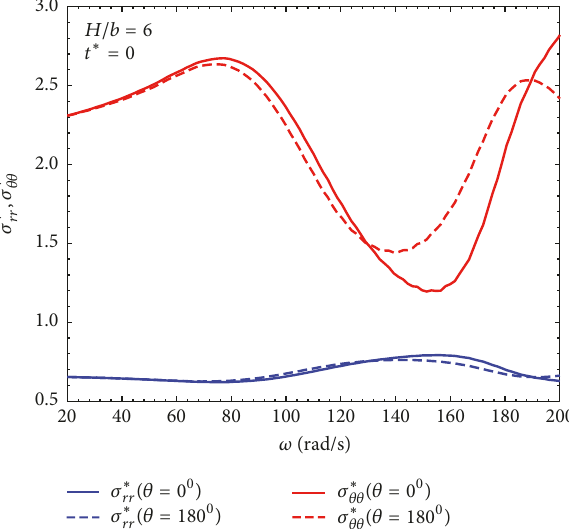
Figure 7: Radial (𝜎 ∗ 𝑟𝑟 ) and tangential (𝜎 ∗ 𝜃𝜃 ) stresses versus frequency at 𝑟 = 𝑏 for 𝜃 = 0 ∘ and 𝜃 = 180 ∘ for a tunnel in hard